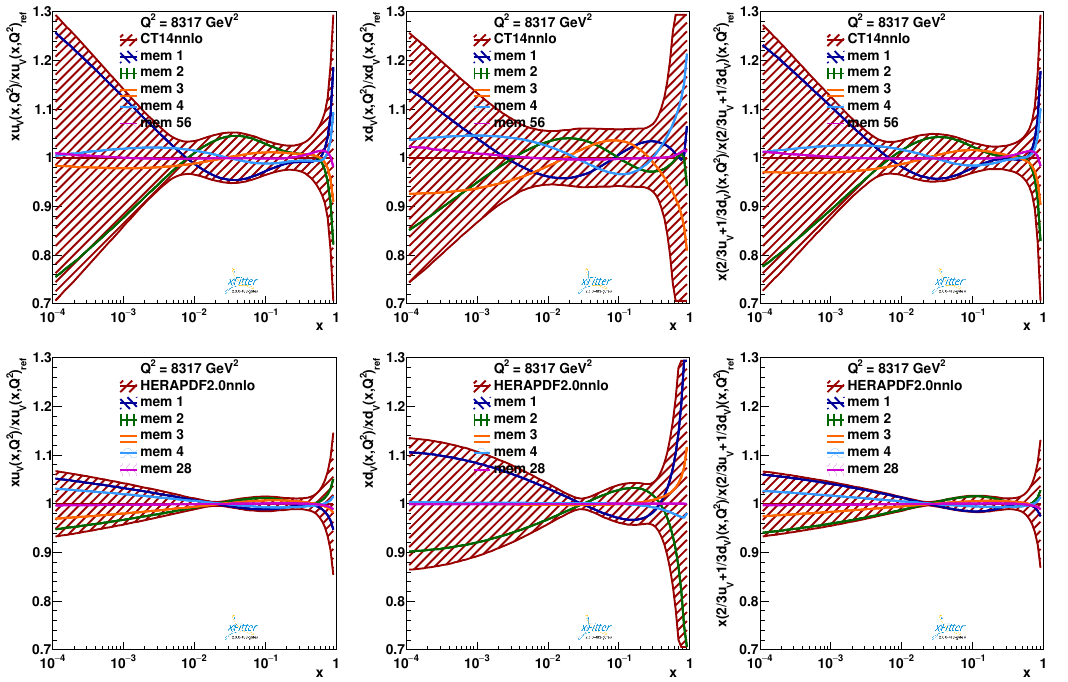
Figure 6 . Contribution of the (cid:12)rst four and last rotated eigenvectors to the uncertainty error bands of the normalised distribution of the ratios of (left to right) u -valence, d -valence and ((2 = 3) u + (1 = 3) d )-valence of the CT14nnlo (top row) and HERAPDF2.0nnlo (bottom row) PDF sets. The eigenvectors are rotated and sorted according to their sensitivity to A (cid:3) to an integrated luminosity of 300 fb (cid:0) 1